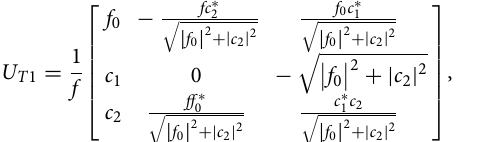
ψ e by R ψ . First, a single qutrit rotation U T 1 assigns the three | �